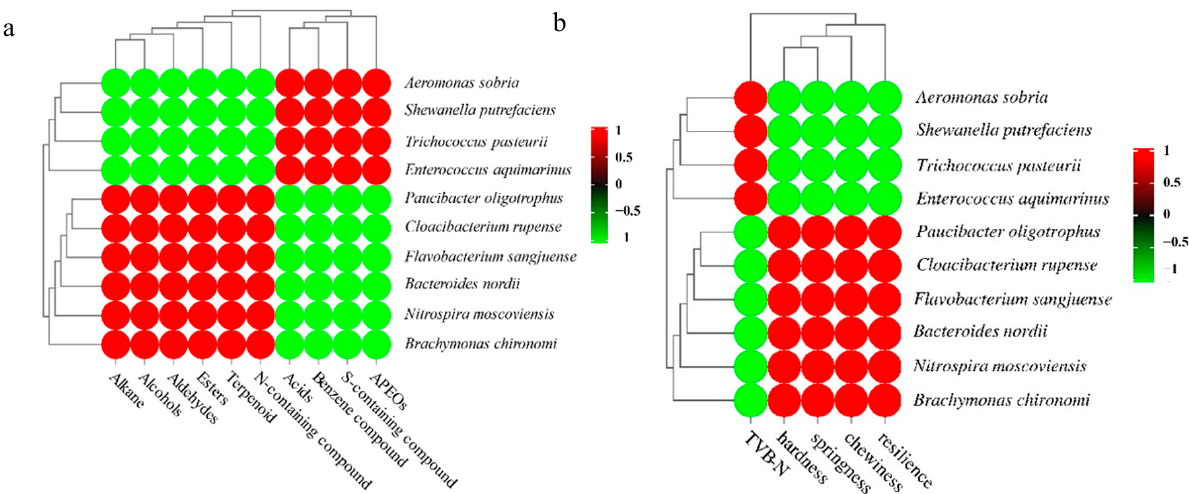
Figure 6. Correlation heatmap of dominant bacteria and quality (volatile flavor compounds ( a ) and TVB-N, texture ( b )).